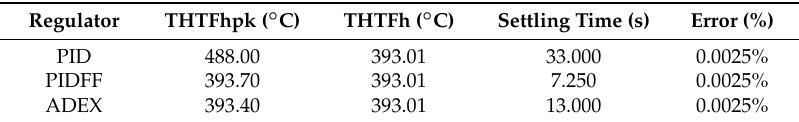
Figure 8. Mass flow response to a sharp DNI, for the PID-FF ( a ) and ADEX ( b ) controllers.